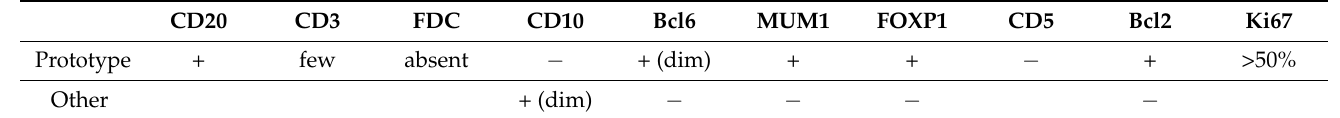
Table 2. Primary cutaneous diffuse large B-cell lymphoma, leg type (PCDLBCL-LT) immunohisto-